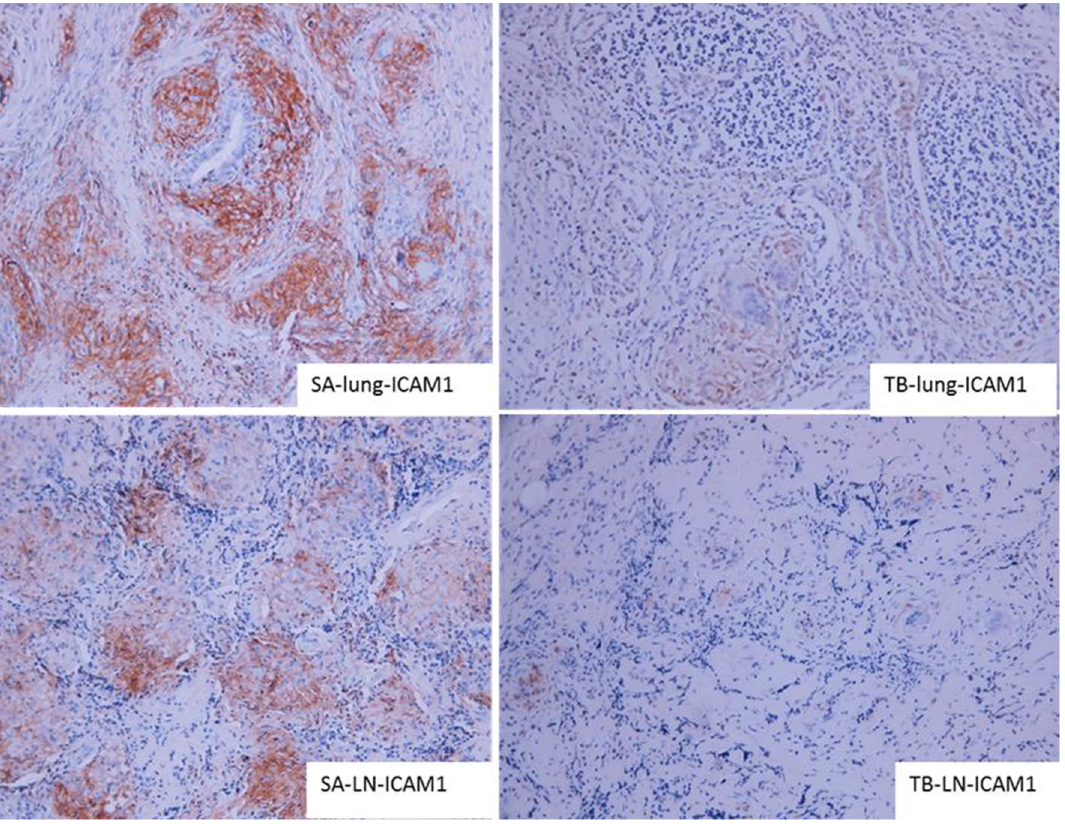
Fig 5. IHC analysis of lung sections from patients in the SA and TB groups. Staining for ICAM-1 is shown (×200). ICAM-1 showed scattered, clustered, strong expression in the lungs and lymph nodes of patients in the SA group but exhibited nonspecific staining or weak expression in the lungs of patients in the TB group. Additionally, a hazel-colored region was observed in the tissues adjacent to the granuloma (Fig